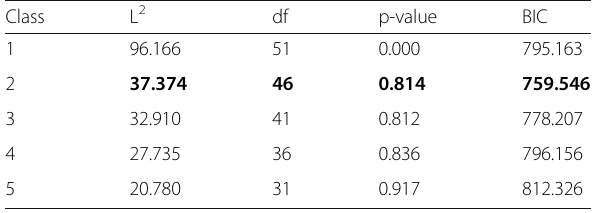
Table 2 Goodness-of-fit of each class